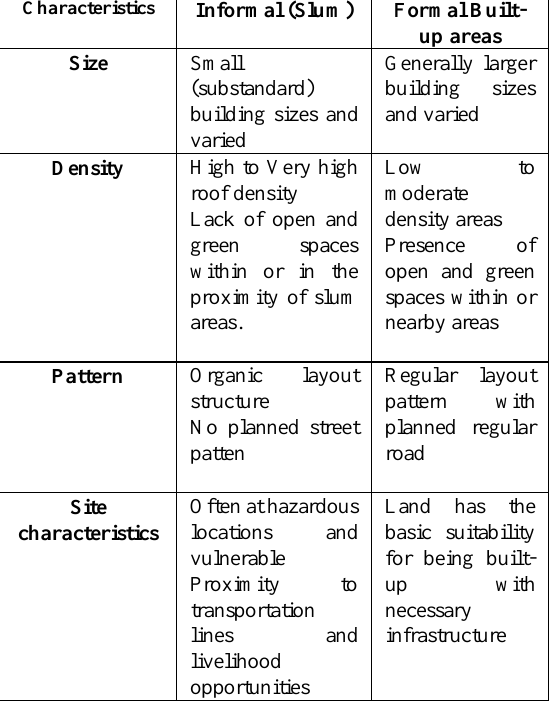
Table 1. Morphological features typical for slum areas (Adapted from Kuffer et al., 2016; Aminipouri et al., 2009)